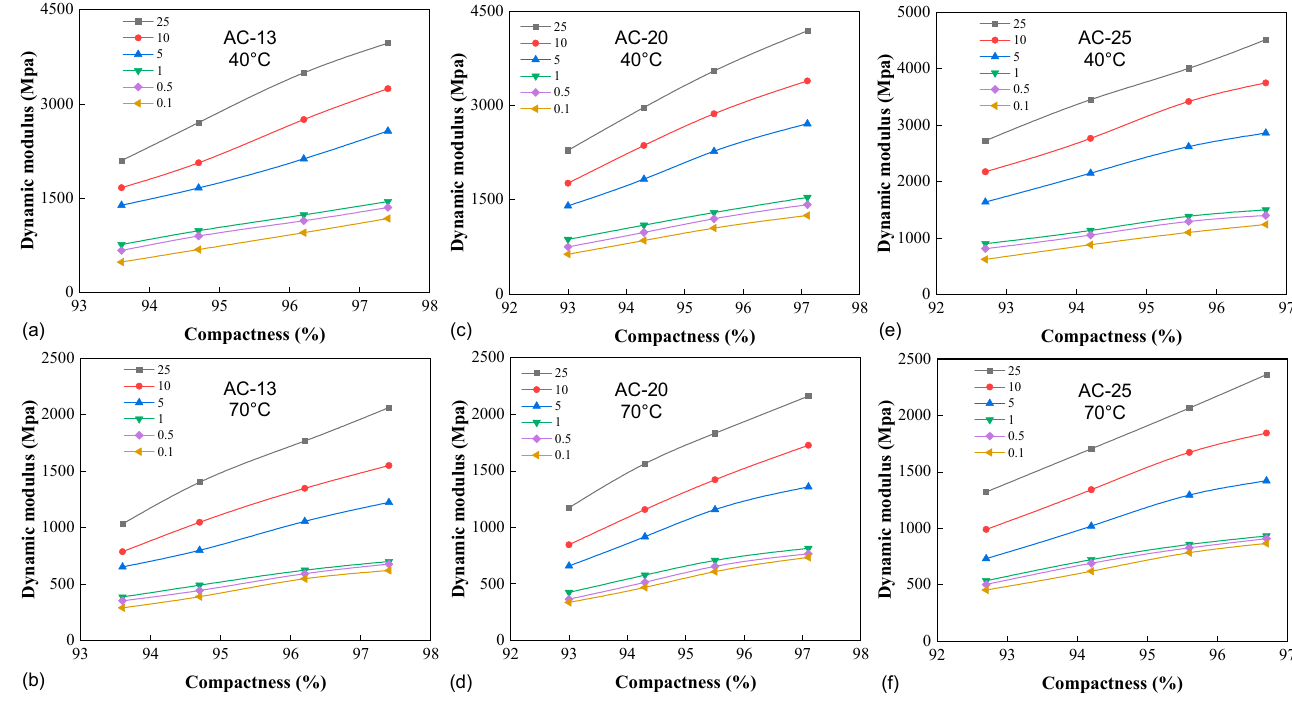
Figure 6. The effect of compactness: ( a ) AC-13 (40 °C), ( b ) AC-13 (70 °C), ( c ) AC-20 (40 °C), ( d ) AC-20 (70 °C), ( e ) AC-25 (40 °C), and ( f ) AC-25 (70 °C).